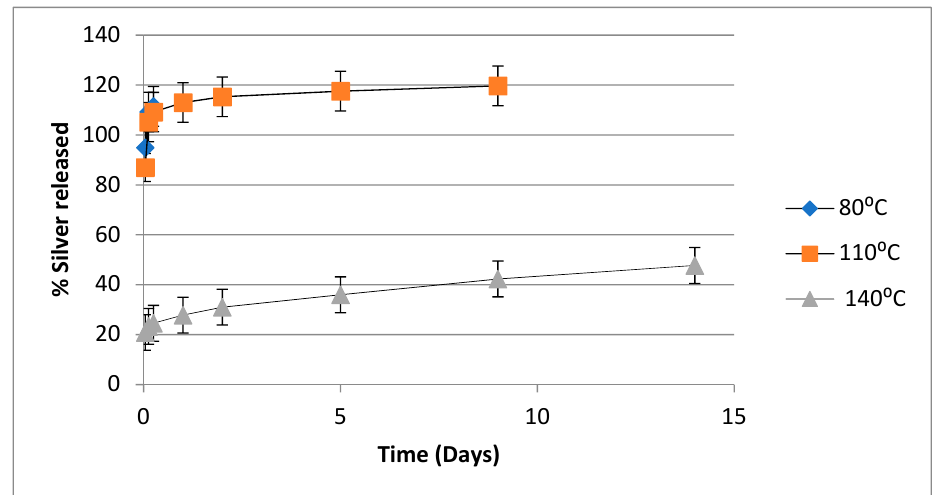
Figure 7. In vitro release of silver from PVA/silver nitrate films in water as a function of temperature after films with 5% silver nitrate loading have been heated at 80, 110 and 140 ◦ C for 90 min.